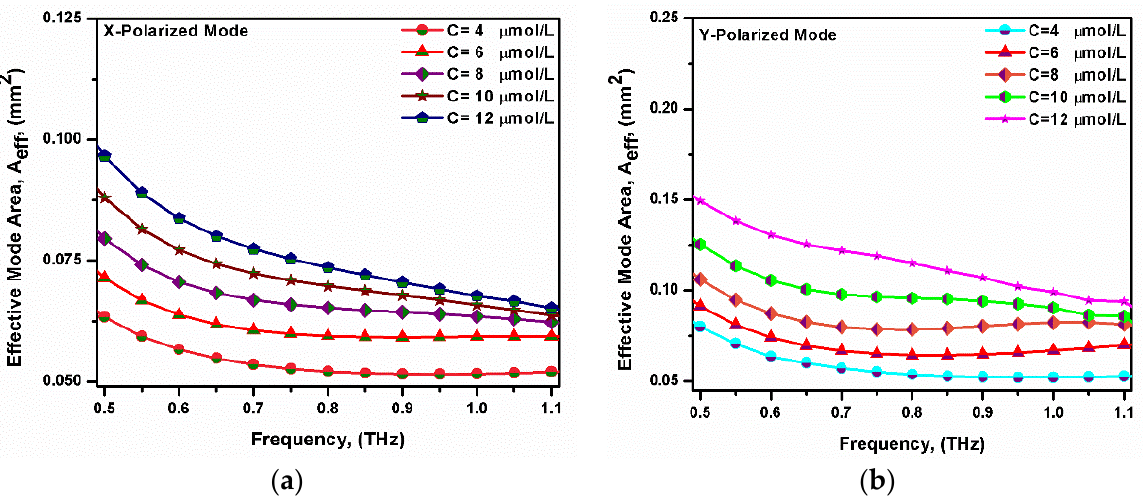
Figure 6. Variation in the effective mode area with the frequency for the fundamental ( a ) x-polarized mode and ( b ) y-polarized mode at different bilirubin concentrations.